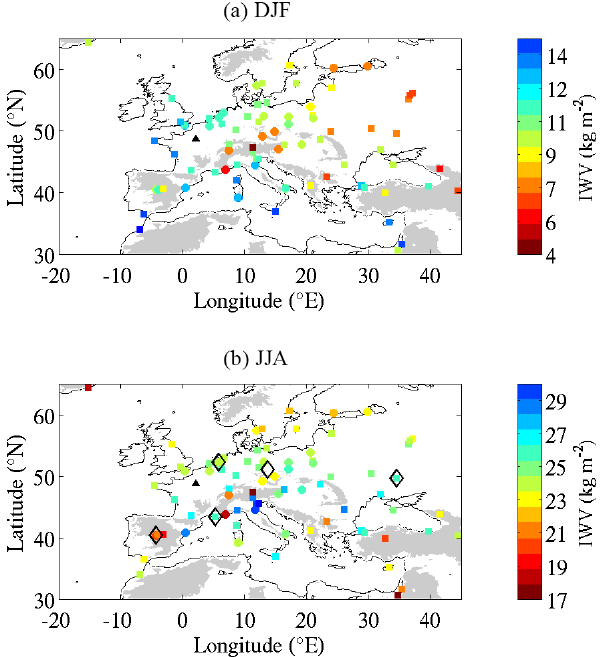
Figure 1. Mean values of IWV in winter (a) and summer (b) re- trieved from GPS network. Note that color scales are different be- tween winter and summer. Circles indicate stations with more than 10 years of observations between 1995 and 2008 and squares indi- cate stations with 5 to 10 years of observations. SIRTA observatory is shown by the black triangle. Black diamonds indicate the location of stations considered in Sect. 5.2. Topography higher than 500m above sea level is shaded in